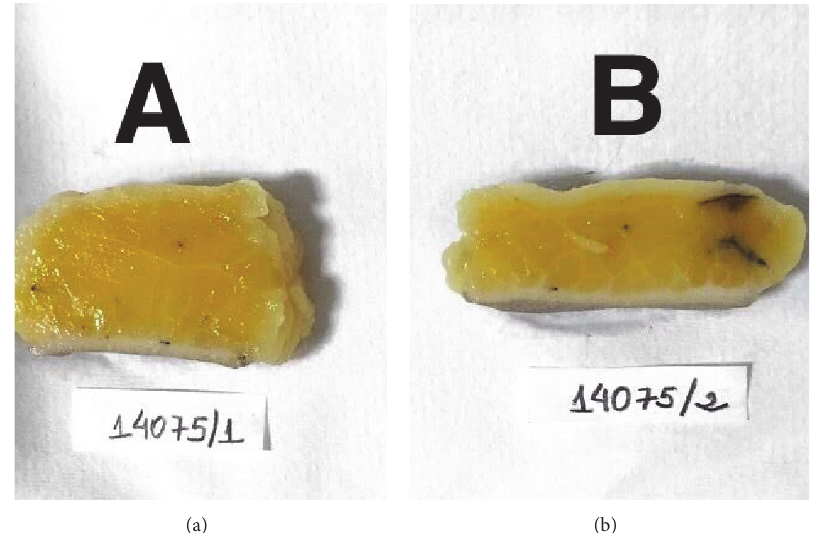
Figure 8: Macroscopic analysis of the material collected during the abdominoplasty surgery. (a) Untreated side with weight of 546 g and size 15 × 10cm. (b) Treated side weight of 508 g and size 15 × 10cm.